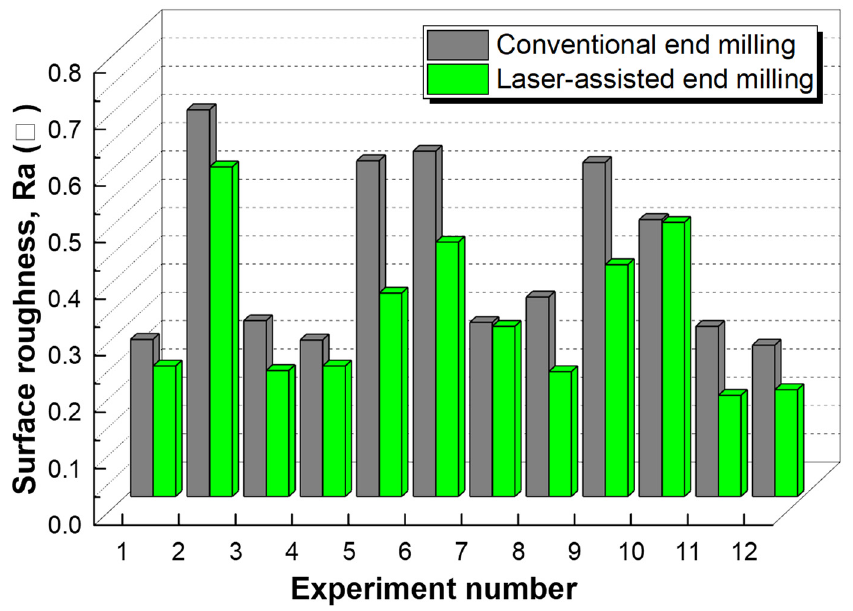
Figure 8. Results of surface roughness measurements.